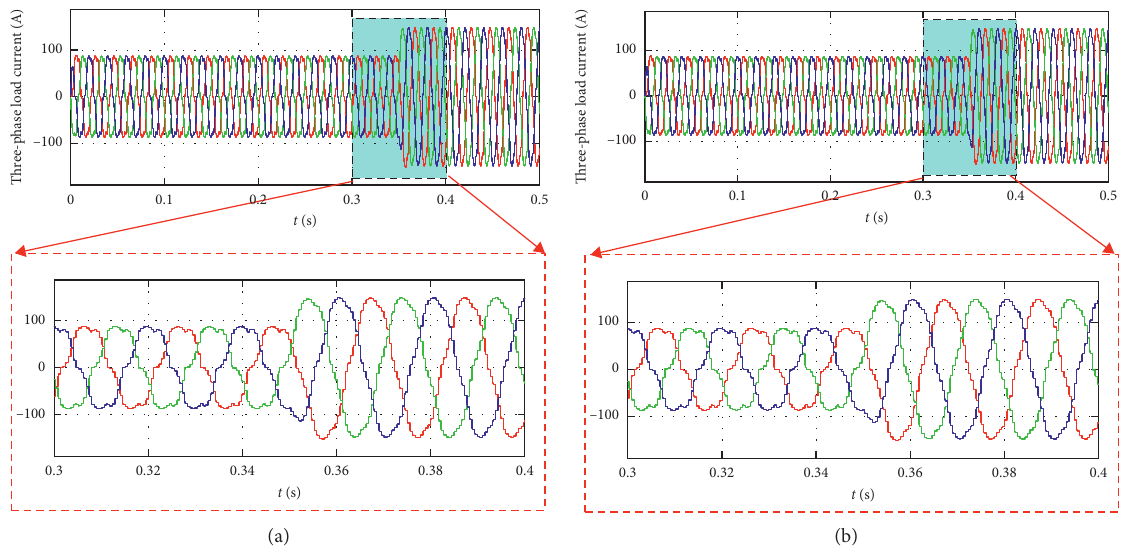
Figure 9: Three-phase load current of the grid-connected system. (a) PV. (b) PV